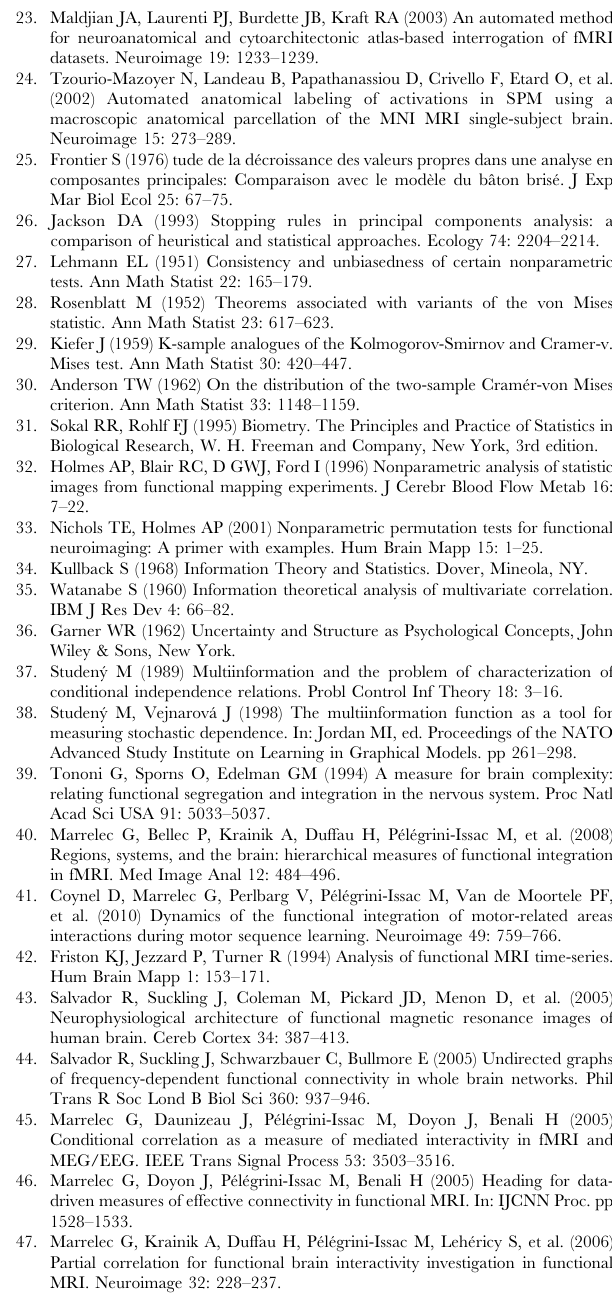
Table S1 Method-specific effect of condition. Method-by- method P -values for an effect of condition. MDS is performed on the components obtained for a given method after MDS on all the data. MDS * is performed on the components obtained for a given method after MDS on the data corresponding to that method only. Table S2 Condition-specific effect of method. Condition-by- condition P -values for an effect of method. MDS is performed on the components obtained for a given method after MDS on all the data. MDS * is performed on the components obtained for a given